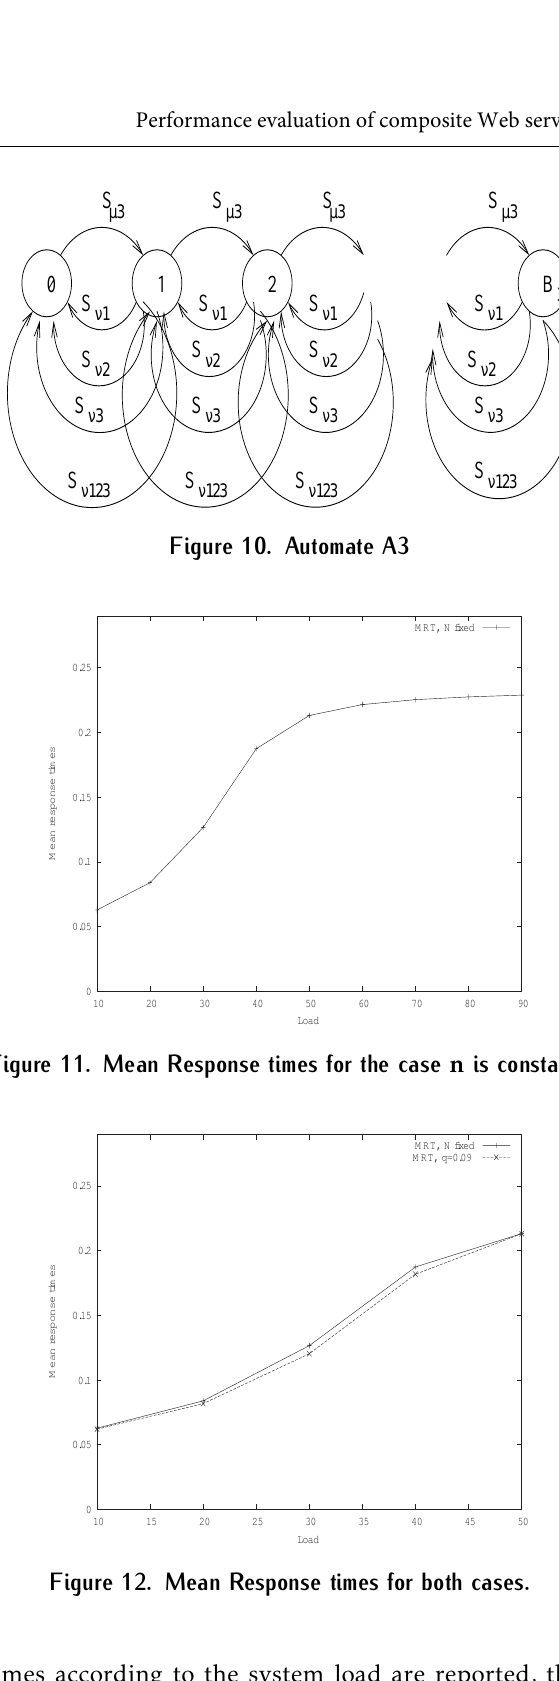
times according to the system load are reported, thus comparing both models. In figure 13, we compare the performances of both models by computing the Figure 9. Automate A2 mean request ratio of both models. As we can see the variability of the number of composed elementary web services has no e ff ect on the behavior of the system comparing where n is